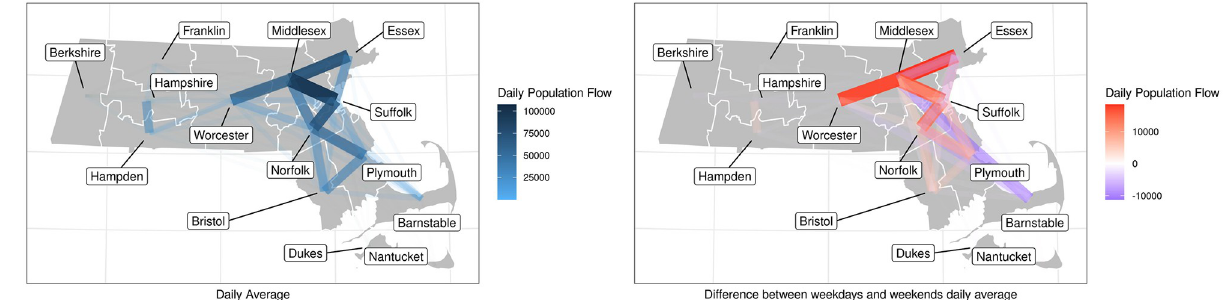
Fig 5. Human mobility network among counties of Massachusetts. The figure on the left shows the average daily population flow, and the figure on the right shows the difference of average population flow between weekdays and weekends, a positive value means the population flow is larger for weekdays than weekends, and a negative value means the population flow is smaller for weekdays than weekends. The maps are created in R and with urbnmapr and ggplot2 packages using data from the US Census Bureau, available at https://github.com/UrbanInstitute/urbnmapr.